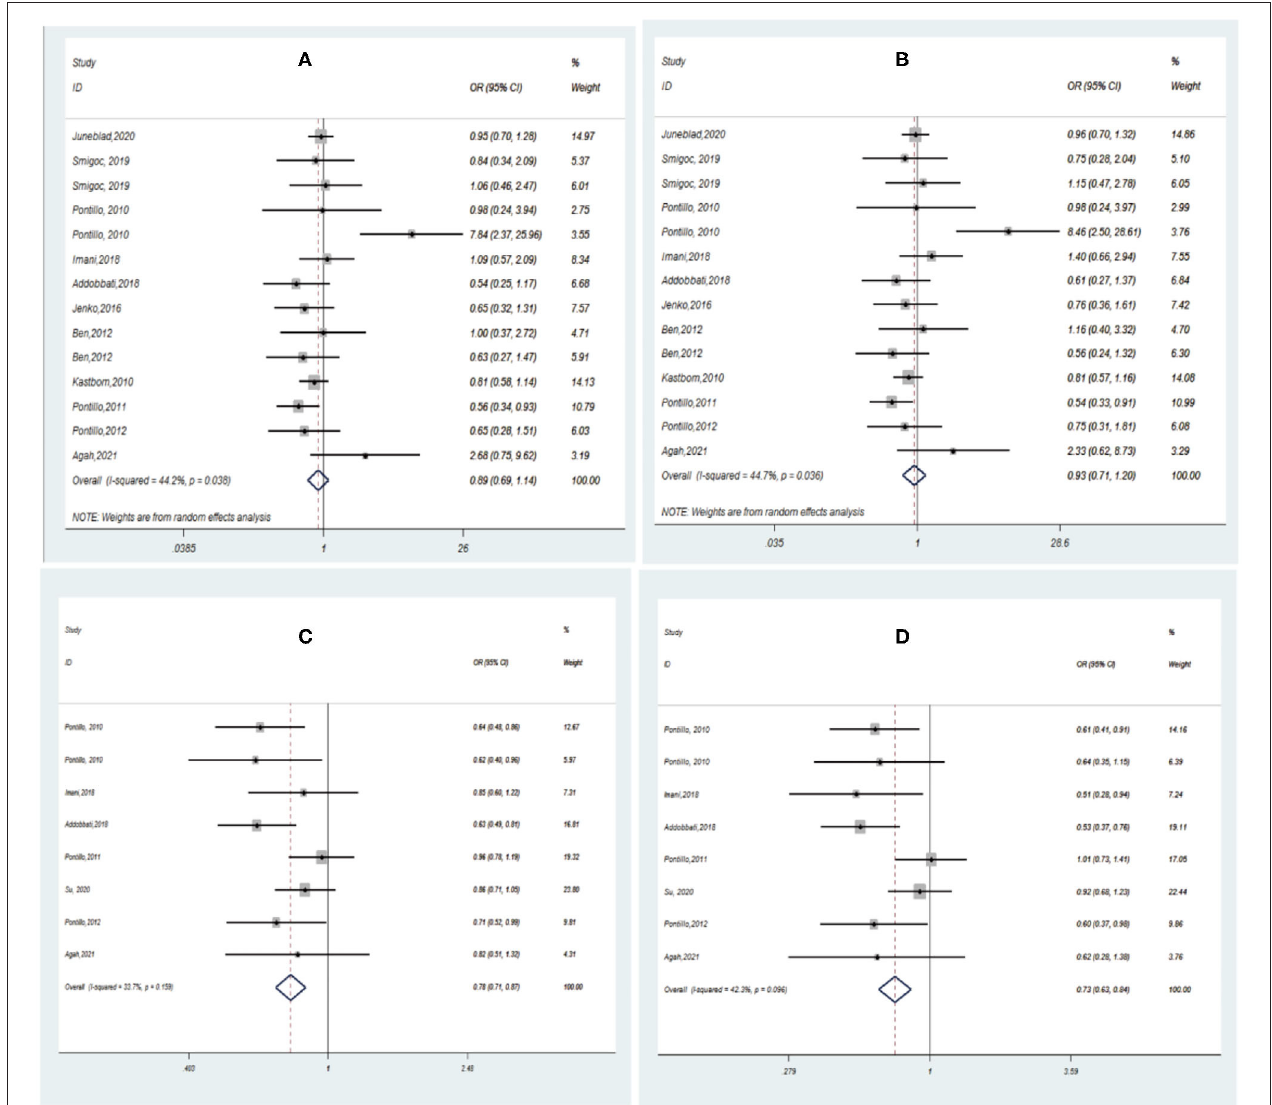
FIGURE 3 | Forest plot of AIDs risk associated with NLRP3 SNPs under the allele/dominant model contrast. (A) A vs. C for rs35829419; (B) AA/AC vs. CC for rs35829419; (C) G vs. C for rs10754558; (D) GG/GC vs. CC for